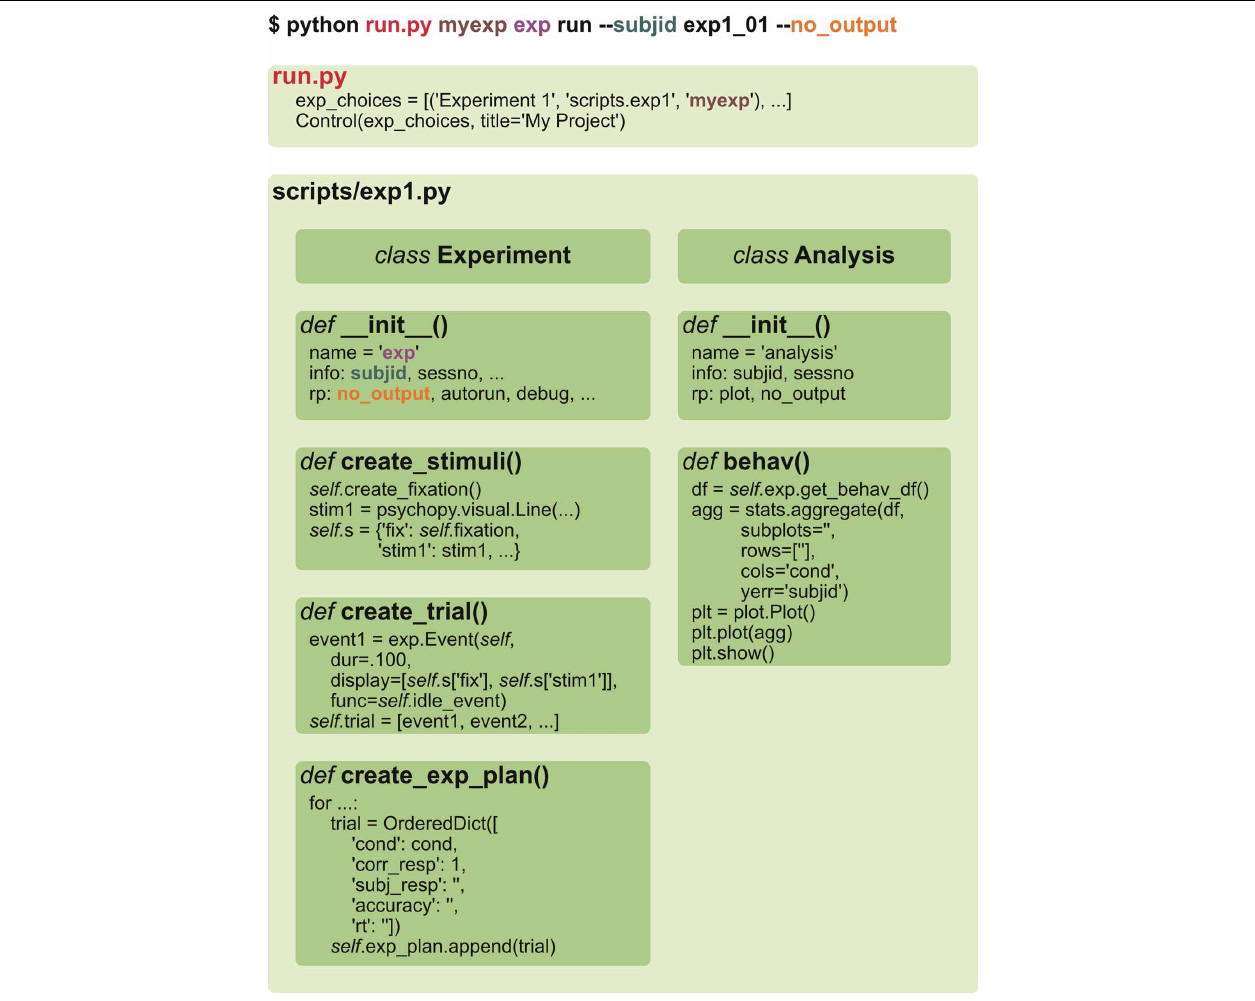
methods (black) are found and performed. A minimal structure of the script is depicted in the lower panel. The user only has to specify stimuli, trial structure, and the list of trials for experiment, and an analysis method for